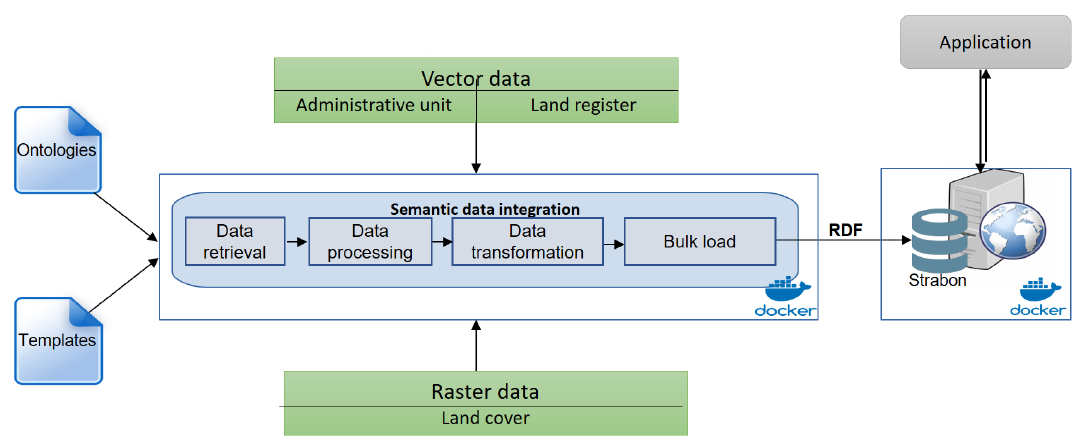
Figure 4. The system architecture based on docker